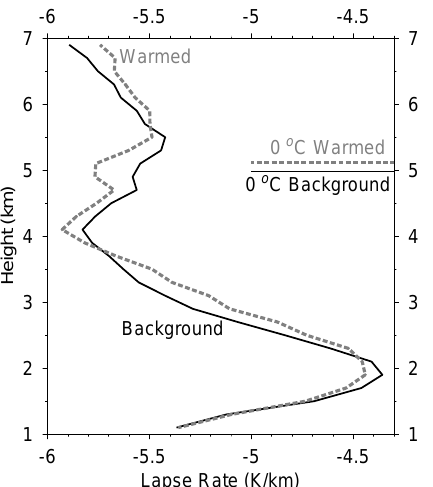
Fig. 7. The black solid curve shows the average lapse rate of the five radiosonde stations during the 10yr period (1999–2008). The dashed gray curve is the lapse rate of a warmed temperature profile subjected to a 1 ◦ C increase in near surface temperature, as described in the text. The horizontal bars denote the approximate heights of the melting level in the background and warmed atmospheres. Surface warming is associated with a shift in the lapse rate profile to a higher altitude, by an amount roughly equal to the displacement in the melting level.